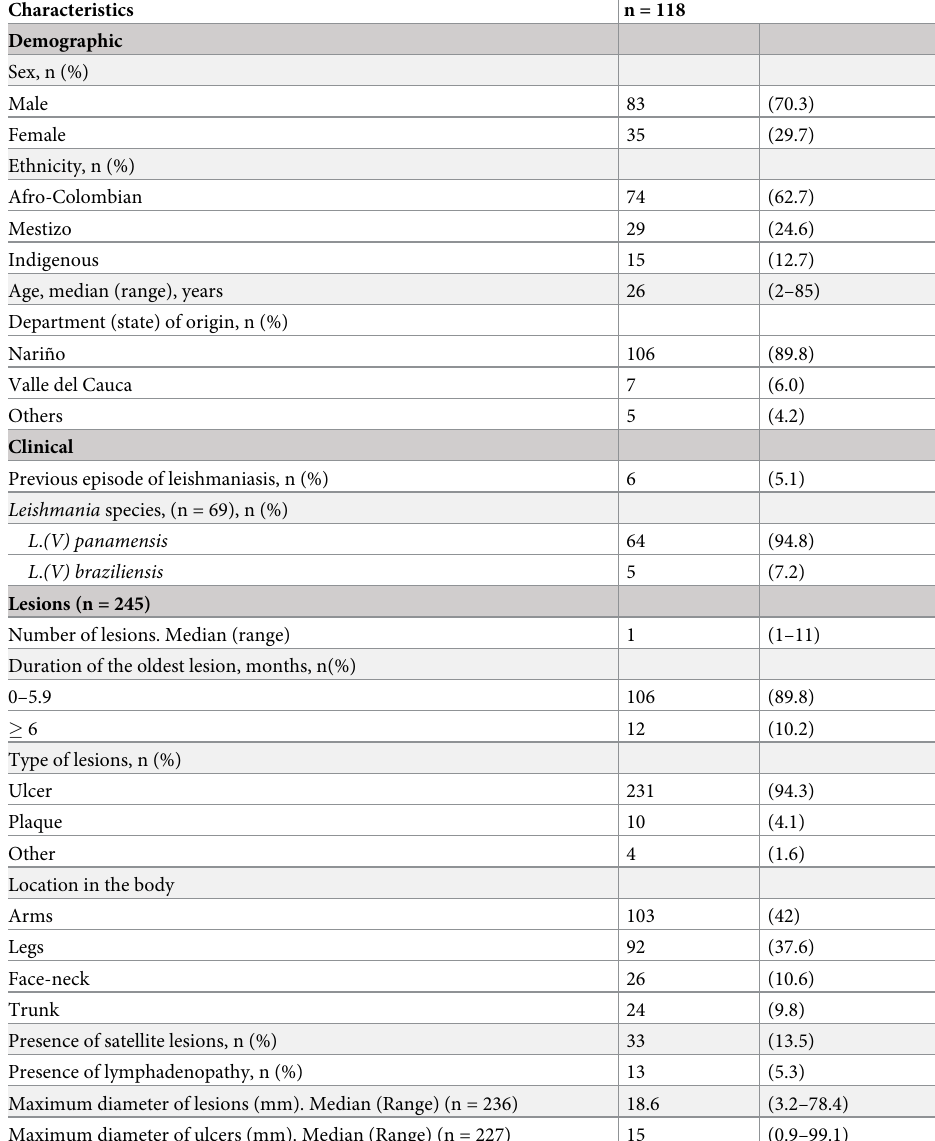
Table 2. Clinical and demographic characteristics of study participants.